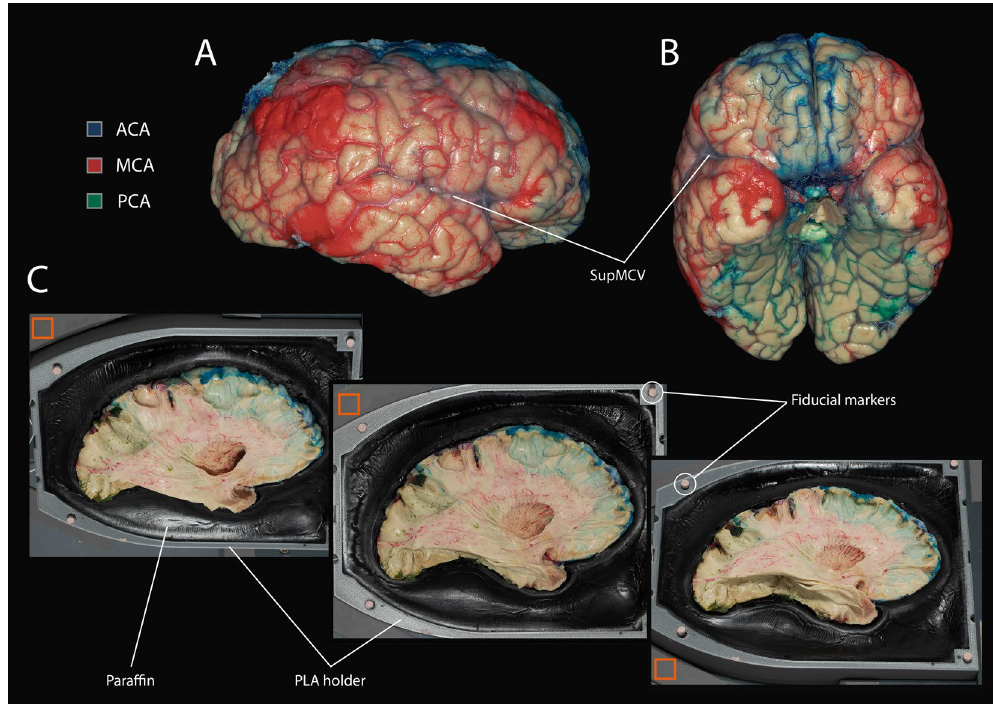
Figure 4. Injection results and 3D-printed holder. ( A ): Right lateral and ( B ): Anterior-inferior views of a human brain injected with colored gelatin (ACAs—blue, MCAs—red, PCAs—green). Pial arteries were filled with the pattern expected from the literature, while the superficial SupMCV remained collapsed. ( C ): Three pictures were taken from different angles to maximize the captured surface: oblique superior (left), orthogonal (middle), and oblique inferior (right). Light gray 3D-printed polylactic holder was filled with black paraffin to fix the position of the specimen. Although the relative position of the holder and cameras was maintained constant by a rigid support, additional fiducial markers (light pink circles) further improved the alignment of different steps images. Reference gray (RGB: 113, 113, 113) color patches (orange squares) are present to correct white balance and exposure precisely. ACA anterior cerebral artery, MCA medial cerebral artery, PCA posterior cerebral artery, SupMCV superficial middle cerebral